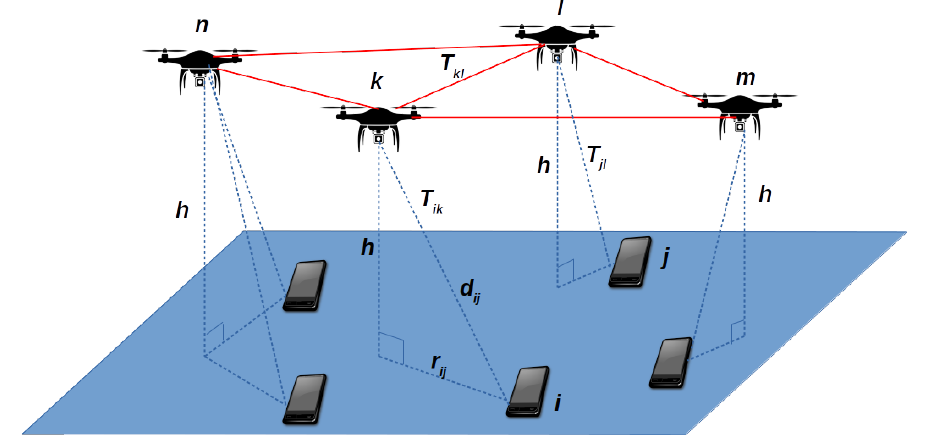
Figure 1. Illustration of a communication between users through user-UAV and UAV-UAV